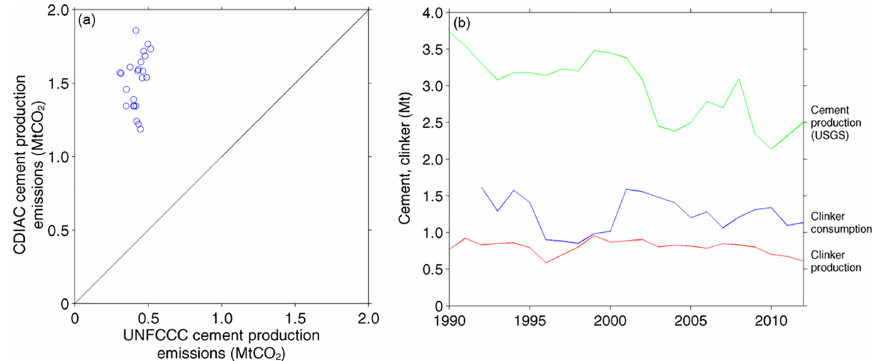
Figure A2. The Netherlands. (a) CDIAC vs. UNFCCC. (b) Clinker, cement. Note that “clinker consumption” is production plus imports less exports, but excludes stock changes. Sources: UNSD, 2015; UNFCCC, 2014; van Oss, 1994–2012; Boden et al.,